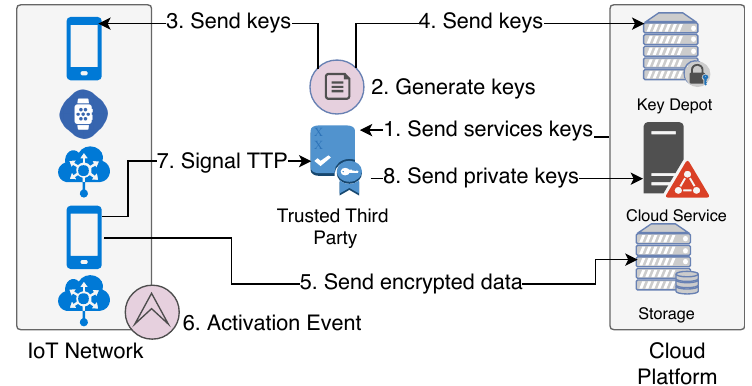
Figure 4. Flexible privacy policy activation scheme. The arrows represent the direction of interaction among the entities. The numbers represent the order and the corresponding